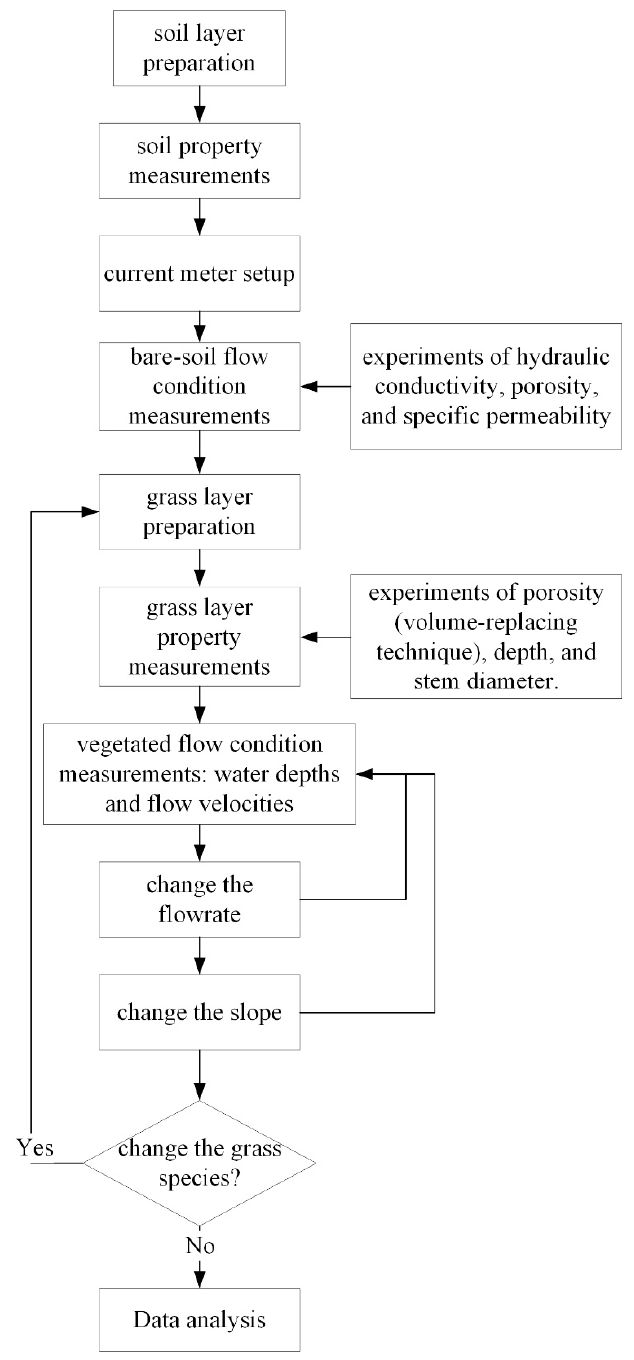
Figure 2. Flow chart of the grassed flow experiments.